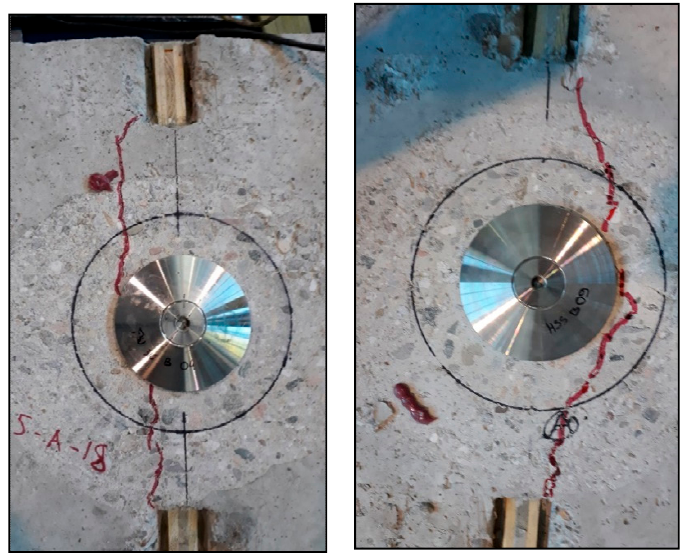
Figure 11. Examples of the preferential path of the crack around the fasteners.